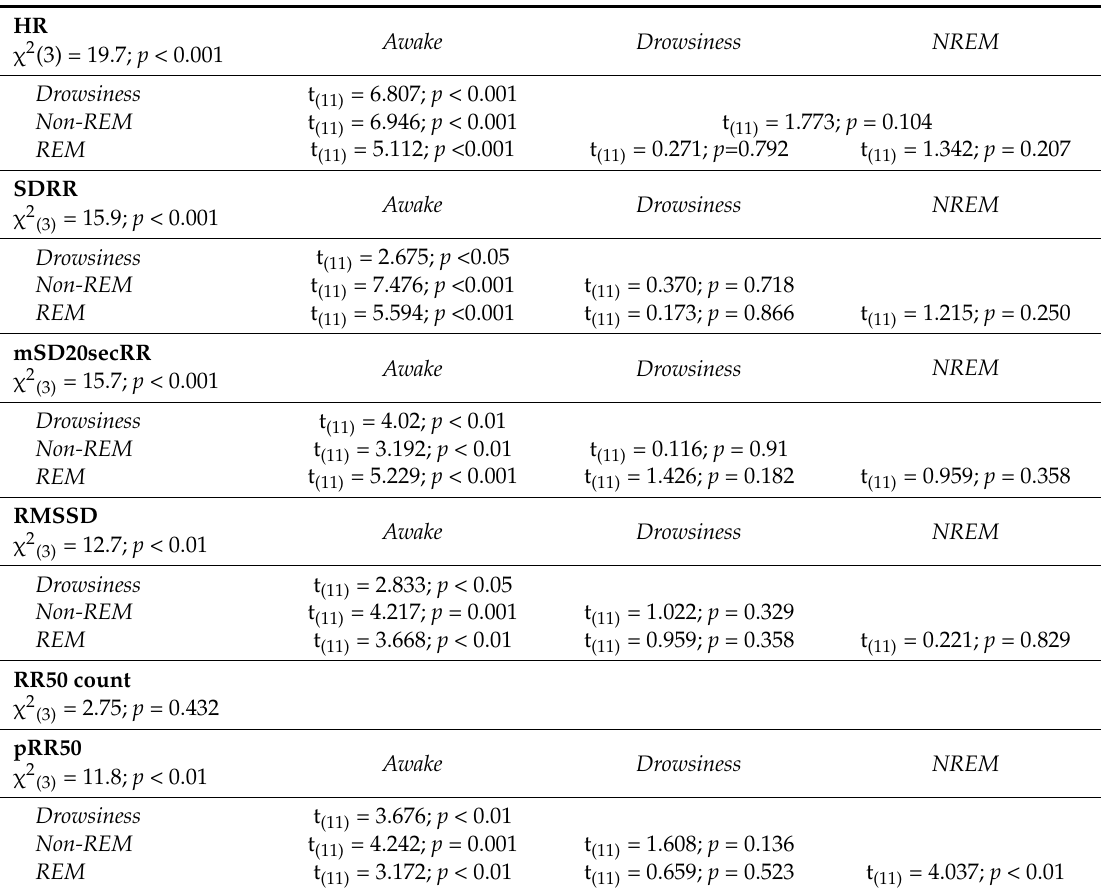
Table 2. Differences between sleep stages using the various ECG parameters calculated based on the longest period of the given stage. Following false discovery rate adjustment differences with a p < 0.01, remain significant at α =